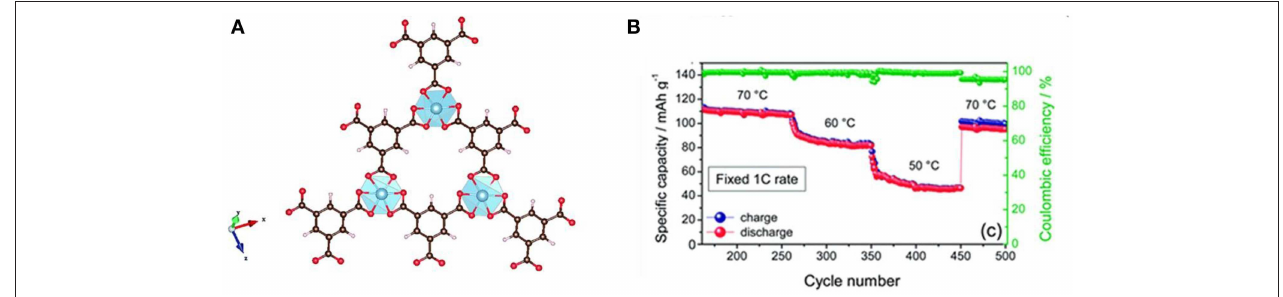
FIGURE 10 | (A) Schematic diagram of the ideal network structure of an aluminum(III)-1,3,5-benzenetricarboxylate (Al-BTC) metal organic framework. (B) Electrochemical characteristics of the LiFePO 4 /S4-NCPE/Li cell at different temperatures and current regimes. [Reproduction with permission from Gerbaldi et al. (2014). Copyright © 2014, The Royal Society of Chemistry].